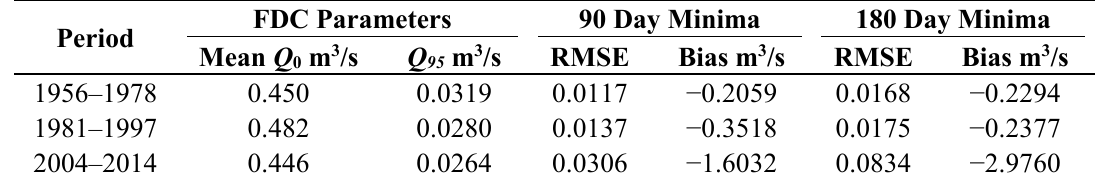
Table 6. Comparison of statistical parameters of approximated FDC by Pearson type III distribution.